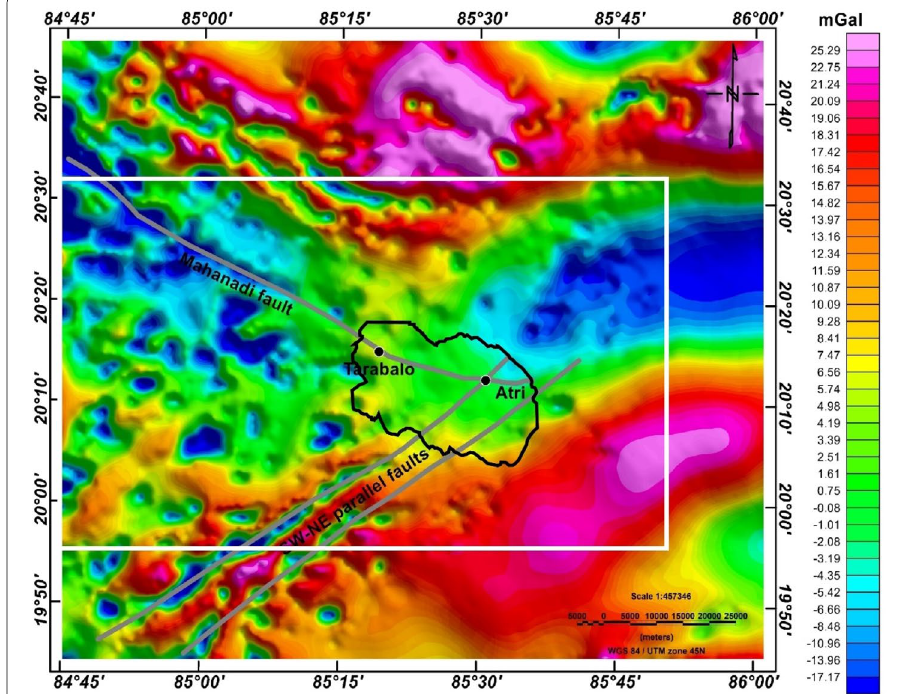
Fig. 2 Bouguer anomaly over wider region along Mahanadi rift basin based on the open- source TOPEX data sets. The black polygonal feature surrounding the hot springs denotes the region covered by land geophysical survey while grey lines show faults in the region and the white square represents the outline of the area covered by the Geology map (Fig.